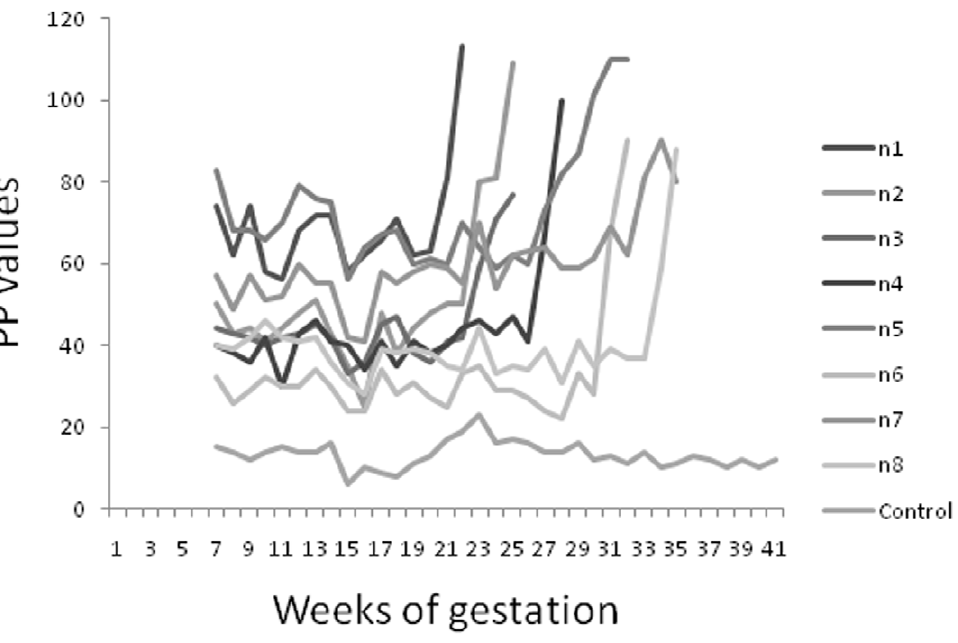
Figure 1. Antibody responses in persistently infected cattle during pregnancy. N. caninum -specific antibody responses were measured weekly in eight naturally, persistently infected cattle (n1–n8) during gestation. Results are expressed as percent positivity (PP) values which are calculated as a ratio of test optical density to the optical density of a high positive control [36]. A cut off value of 25PP was used to indicate an infected cow. All eight cows had positive values ( . 25PP) prior to artificial insemination. Antibody values were measured weekly as soon as pregnancy was confirmed at 6 weeks gestation. For each individual animal, antibody levels were considered to be rising when the PP value increased above the mean + 95% confidence intervals calculated for the PP values for the first six serum samples taken (6–12 weeks gestation). Each cow was killed when the PP value increased to . 50% higher than the mean (6–12 weeks) PP value. This ranged from two to five weeks from the time when an increase in PP value was first detected. The control represents the PP values for one uninfected sentinel cow, housed with the infected